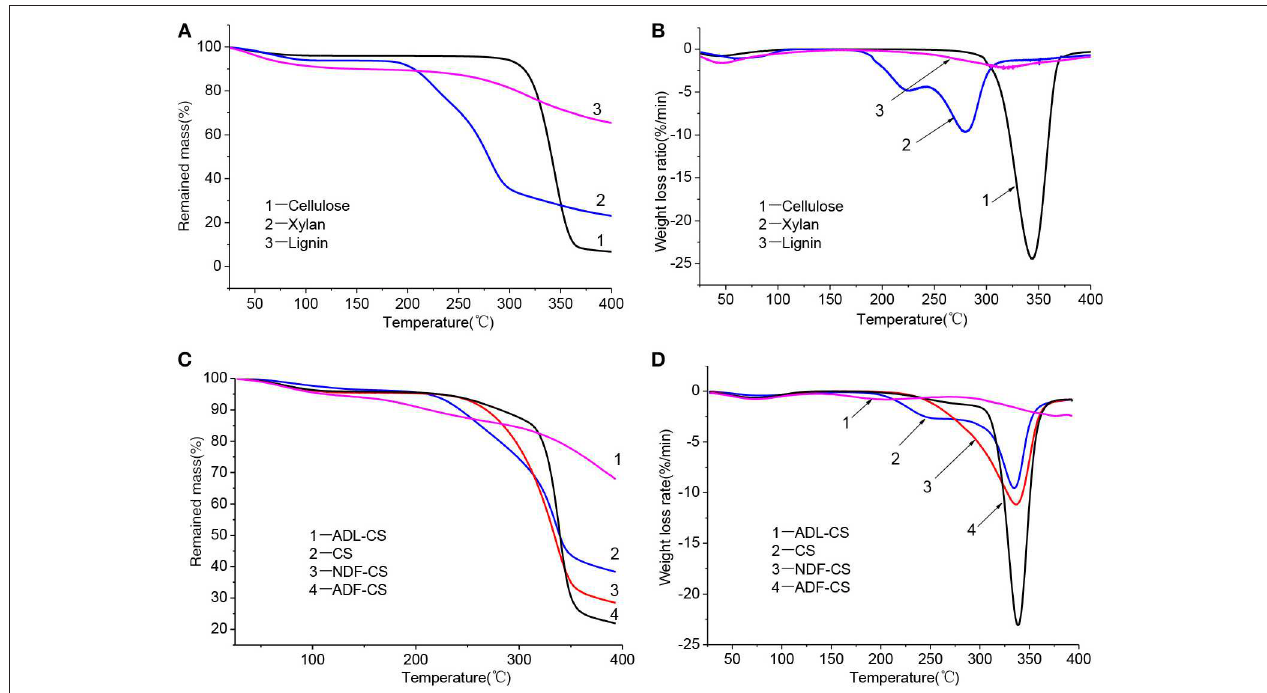
FIGURE 2 | TG and DTG curves for three simplex model compounds (cellulose, xylan and lignin) (A,B) , CS and its detergent fibers (C,D) at low